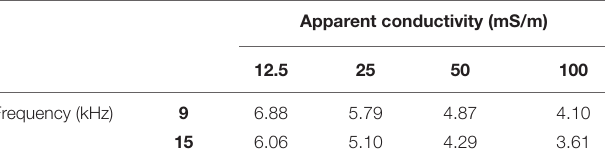
TABLE 1 | Estimated maximum depths of investigation calculated for the range of apparent conductivities measured along the beach at each frequency (units in